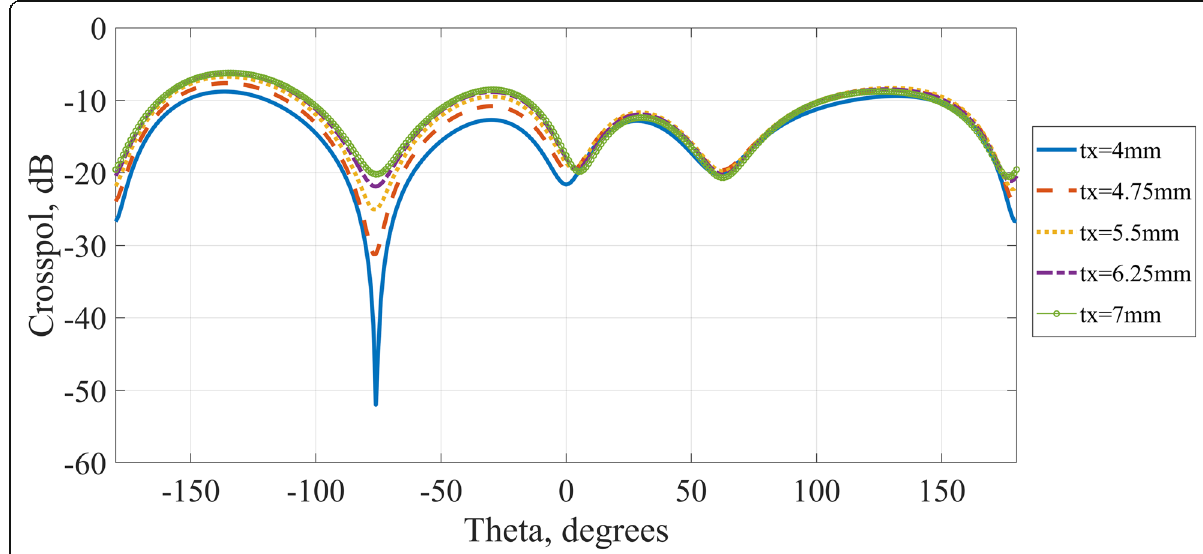
Fig. 6 Effect of the variation of tx (transition width) on cross-polar level for Phi90 plane